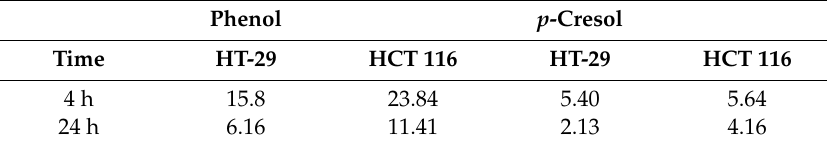
Table 1. Toxicity (IC 50 value, mM) of phenol and p -cresol to HT-29 and HCT 116 cells. Phenol p